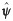
Mean occupancy (ψ^ ±SD, 95% BCI) for the complete study area during 2003–2012, in the regional bird monitoring program in Argentina for Non Passeriformes species.(a) Raptors; (b) ground omnivores and herbivores; (c) ground granivores. For details of species names and guilds, see S1 Table.